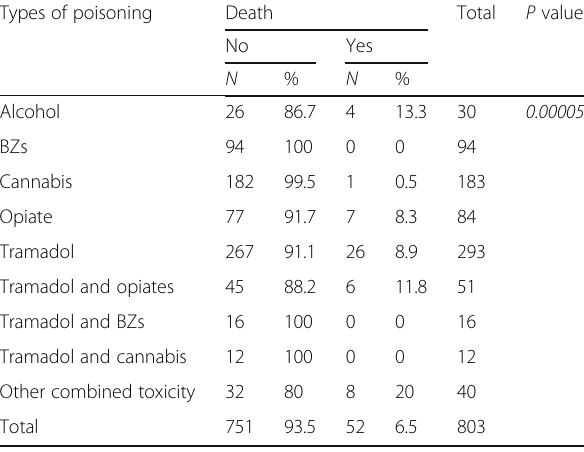
Table 9 The relation between the fate of patients and different types of